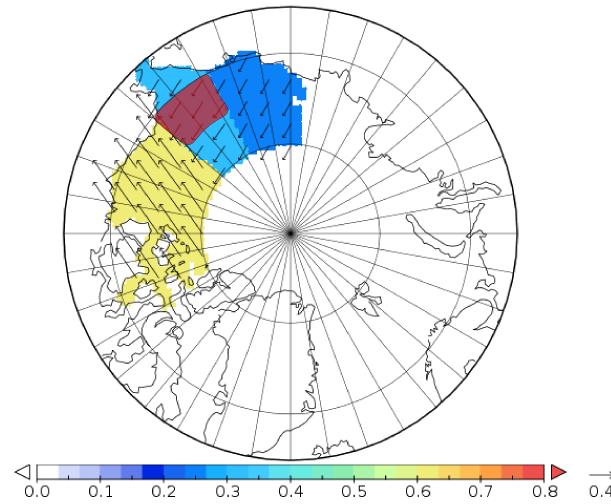
Figure 5. Wind stress direction with highest impact of tau com- ponent in control vector on ice thickness in Chukchi target region (dark red colour). Colour indicates